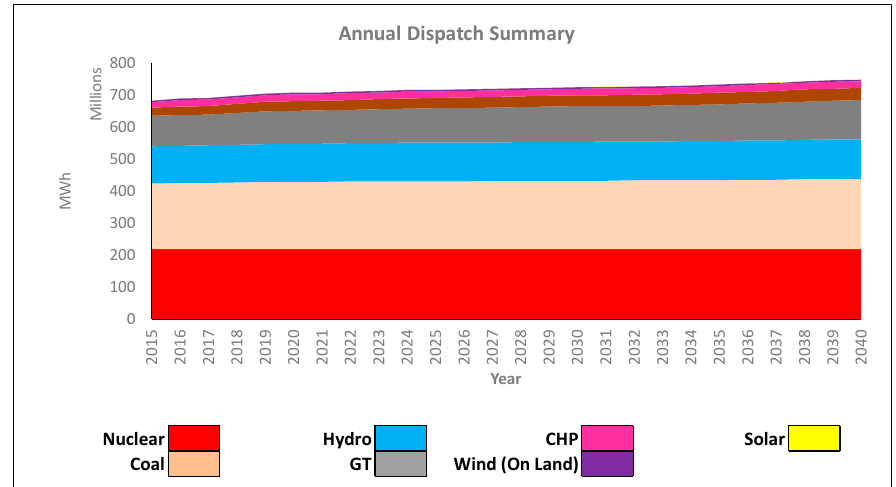
Figure 5. Baseline Model Dispatch Summary.